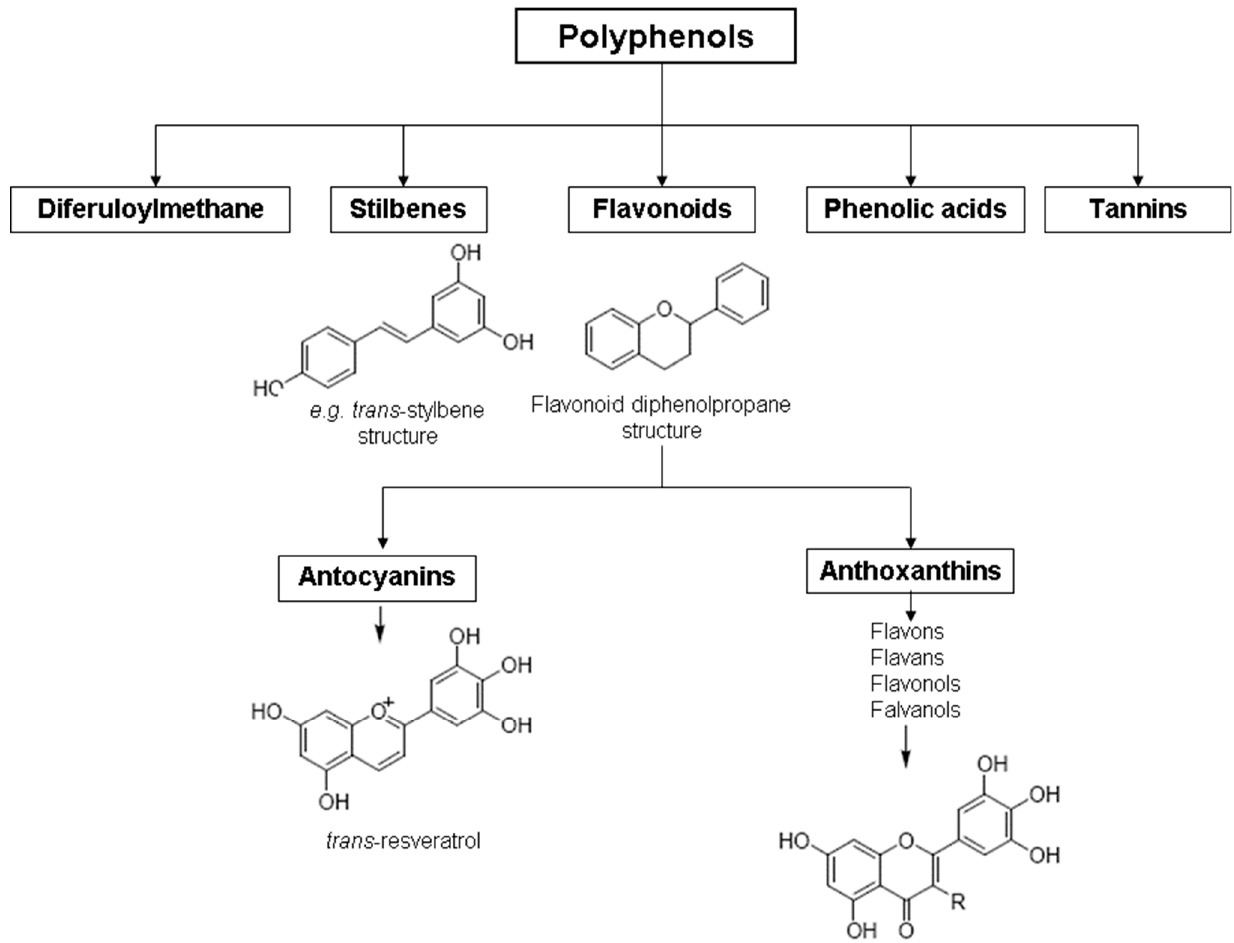
Figure 1. General structure of polyphenols. Table 1. Main groups of polyphenols.